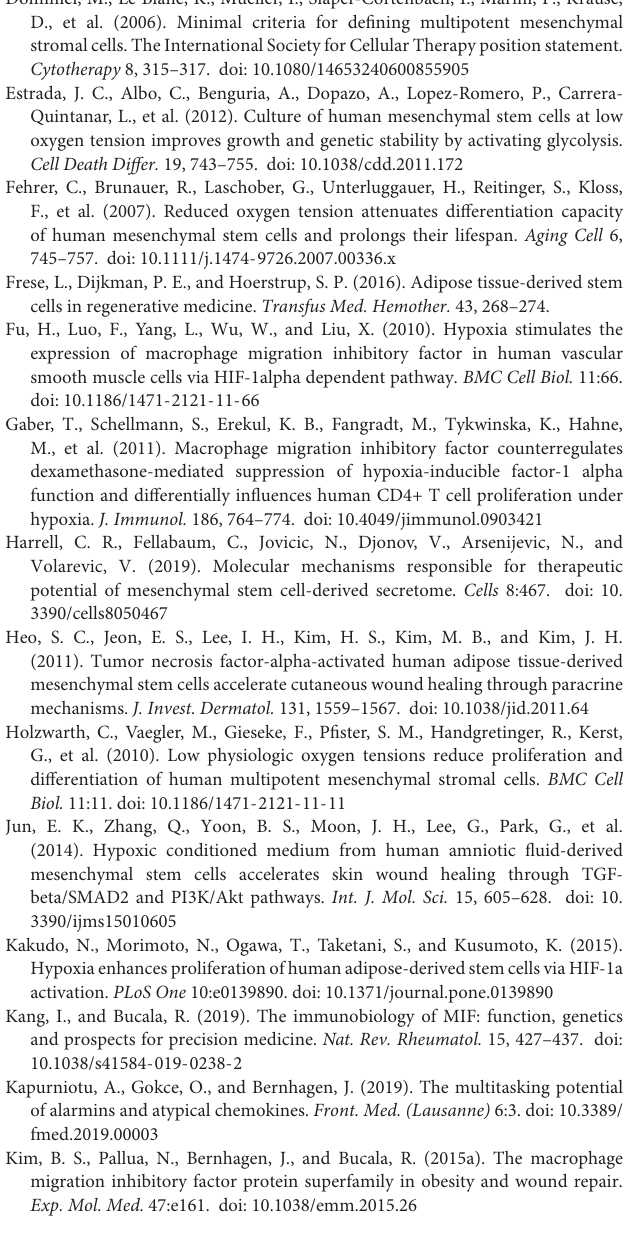
Supplementary Figure 1 | Adipose-derived stem cell (ASC) characterization for osteogenic, chondrogenic, and adipogenic differentiation. The trilinear differentiation of isolated ASCs was measured in vitro be exposing ASCs to osteogenic, chondrogenic and adipogenic differentiation media as reported earlier (Yoshinoya et al., 2020). Osteogenic differentiation was determined by Alizarin red staining (top), chondrogenic differentiation by Alcian blue staining (middle) and adipogenic differentiation by oil red O staining (bottom). Supplementary Figure 2 | Adipose-derived stem cell (ASC) characterization by flow cytometry. The surface marker expression of ASCs was examined by flow cytometry. ASCs were defined as cells with no expression of the endothelial marker CD31 and hematopoietic marker CD45. ASCs were positive for the stem cell markers CD34, CD73, CD90, and CD105 to various